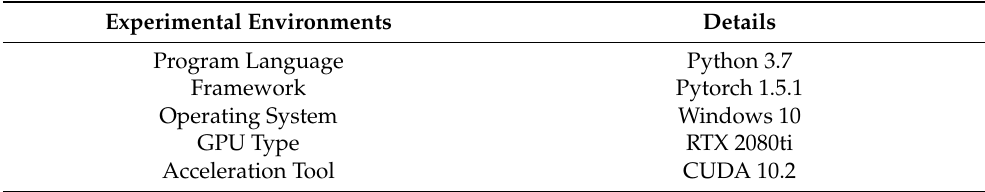
Table 1. Experimental